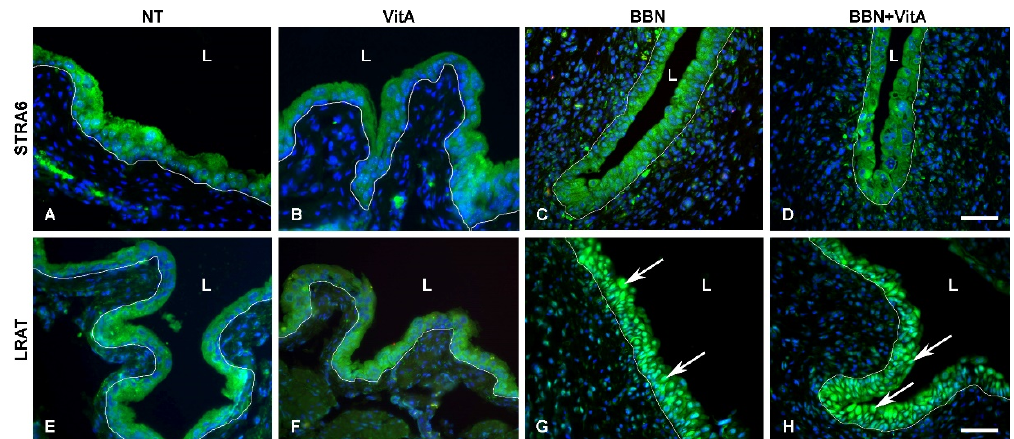
Figure 7. Immunofluorescence of proteins stimulated by retinoic acid 6 (STRA6) and lecithin retinol acyltransferase (LRAT). ( A – D ) STRA6 labelling (green) is strong in the cytoplasm of urothelial cells of all groups. Scale bar = 50 μ m. LRAT labelling (green) is present in the cytoplasm of the normal urothelial in ( E ) NT and ( F ) VitA groups. In ( G ) BBN and ( H ) BBN + VitA groups, LRAT labelling is strongest in the nuclei of urothelial cells (arrows). White line depicts the location of basal lamina, L, lumen. Scale bar = 50 μ m.